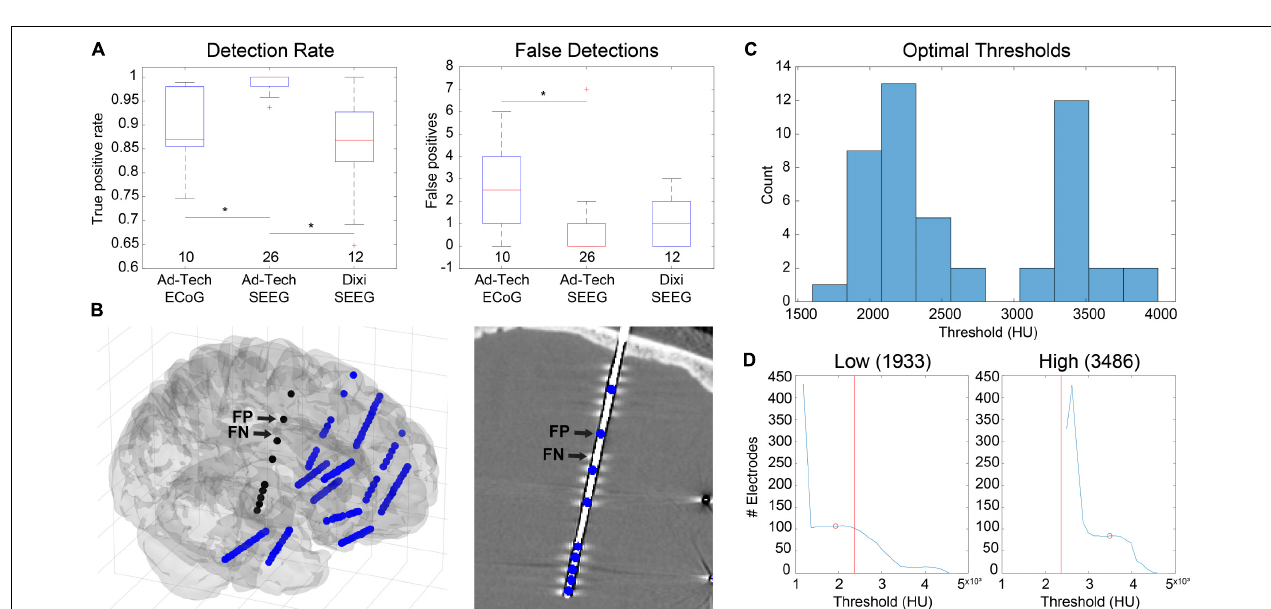
FIGURE 3 | Automatic electrode detection results from 48 datasets containing 4695 total electrode contacts including ECoG and SEEG. (A) True-positive detections (left) and false positive detections (right) grouped by electrode type. Ad-Tech SEEG electrodes performed the best, with a median detection sensitivity of 1 and false-positive count of 0. Values under each boxplot indicate number of datasets included. Asterisks indicate significance (pairwise rank-sum, p < 0.01). (B) Example of false positives (FP) and false negatives (FN) for a dataset that included Dixi SEEG. Electrode locations relative to the brain surface (left) and CT image (right) are shown. (C) Histogram of optimal thresholds in Hounsfield units (HU) for all 48 datasets demonstrates a bimodal distribution with two peaks at 2200 and 3400 HU. (D) Examples showing the number of detected electrodes as a function of threshold for two datasets with both a low (left) and a high (right) optimal threshold (red circle). The overall median threshold (2365 HU) for all 48 datasets is indicated with a red vertical line.